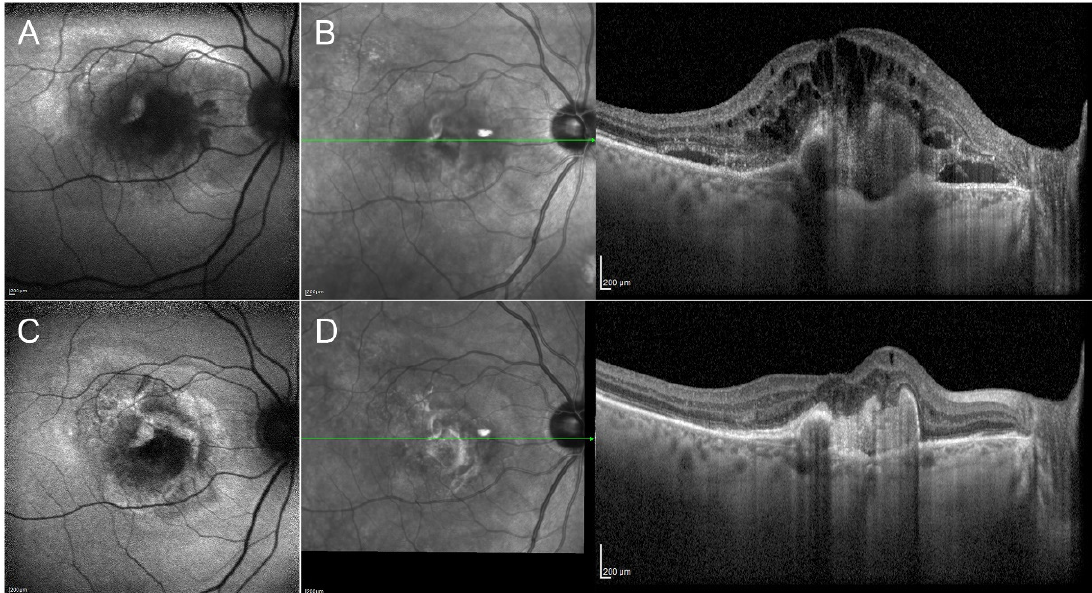
Figure 1. Clinical efficacy of anti-VEGF injections in macular neovascularization secondary to age-related macular degeneration. The onset of the neovascularization is characterized by evident changes of the fundus autofluorescence signal ( A ). Structural OCT describes a completely altered macular profile, with the presence of wide subretinal and intraretinal exudation ( B ). After the loading dose of three-monthly intravitreal injections of anti-VEGF, it is possible to observe an improvement of the fundus autofluorescence profile ( C ), together with the complete regression of the exudation detected by structural OCT ( D ).